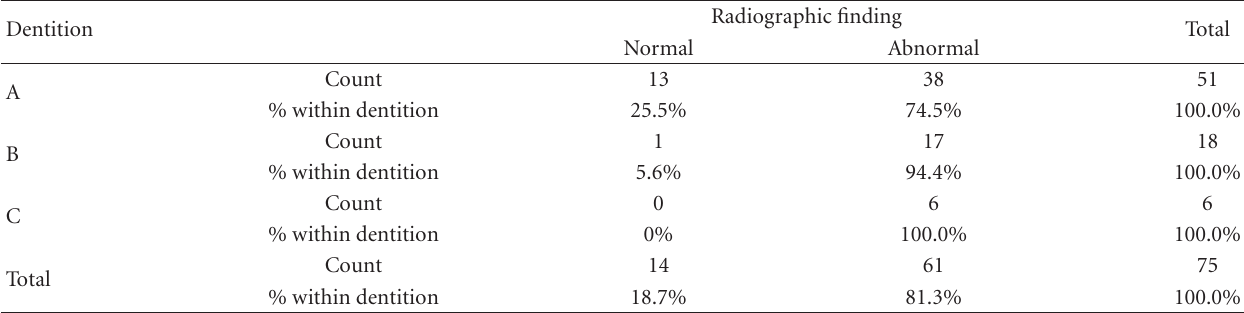
Table 7: Association between radiographic changes in condyles and dentition status.